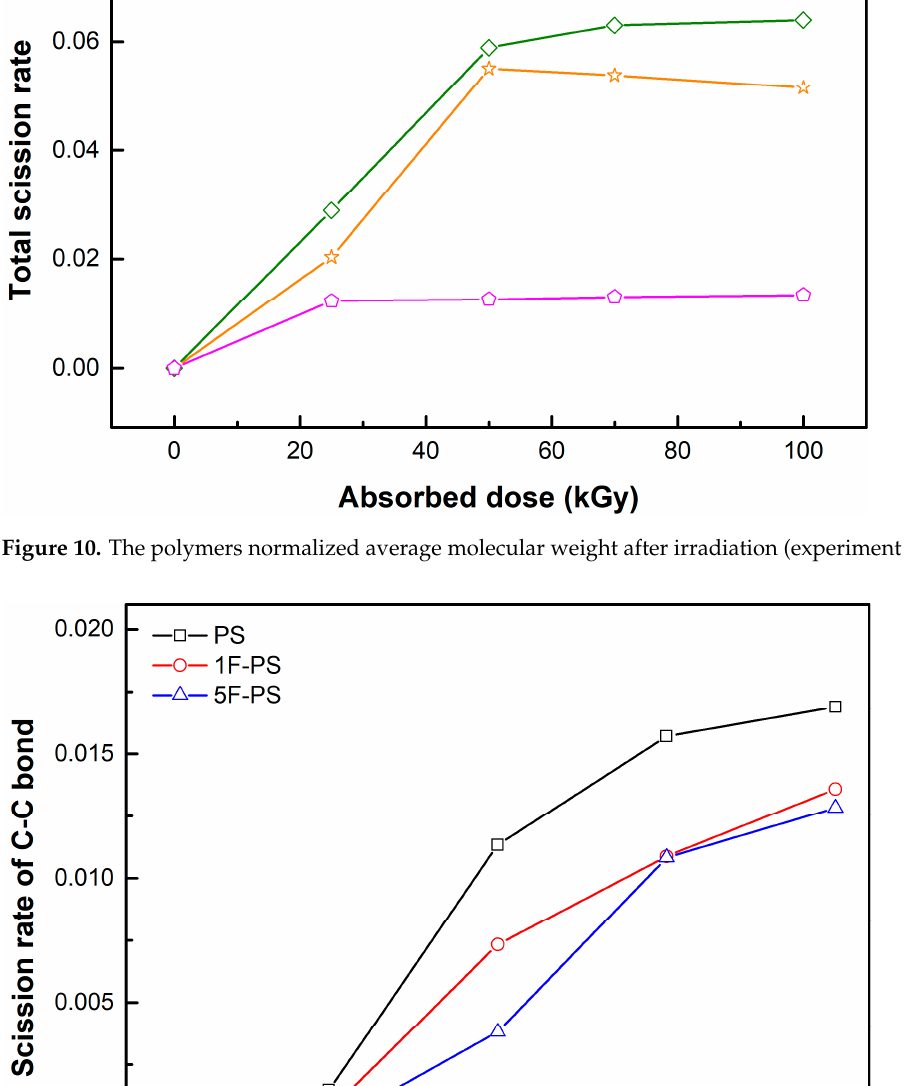
number: the ratio between the average molecular weight of atoms (experiment results) and atom number (simulation value) after irradiation. The scission rates of the bonds which were simulated in the polymers are shown in Figures 11–13.